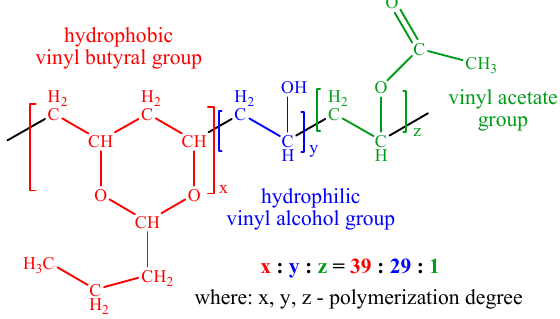
Figure 4. Molecular structure of poly (vinyl butyral-co-vinyl alcohol-co-vinyl acetate).